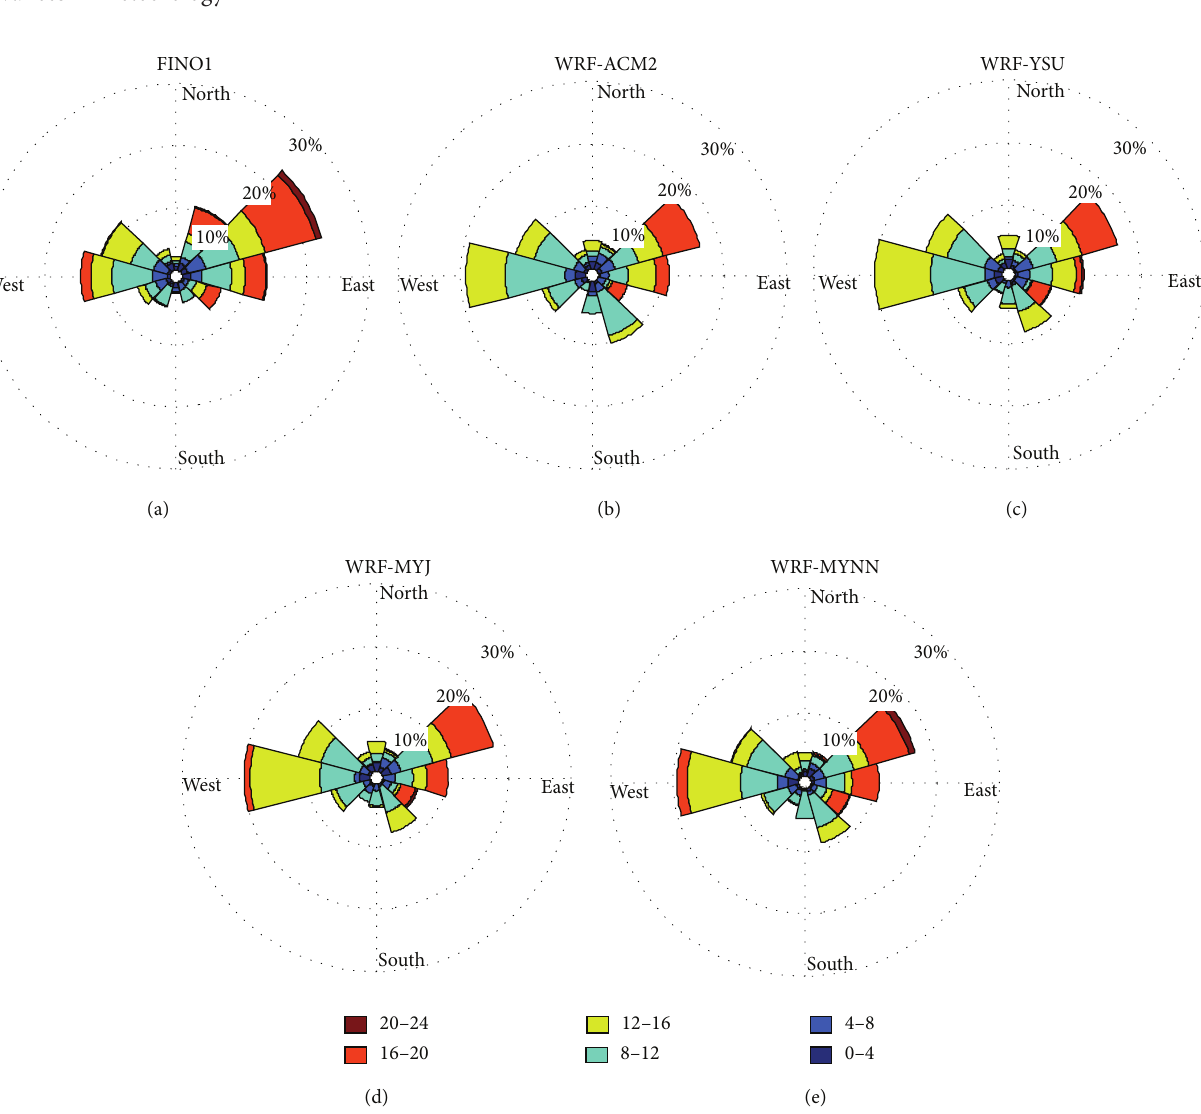
Figure 8: Wind roses based on March 2005 data from the FINO1 measurements and the WRF PBL runs (ACM2, YSU, MYJ, and MYNN) at 100m